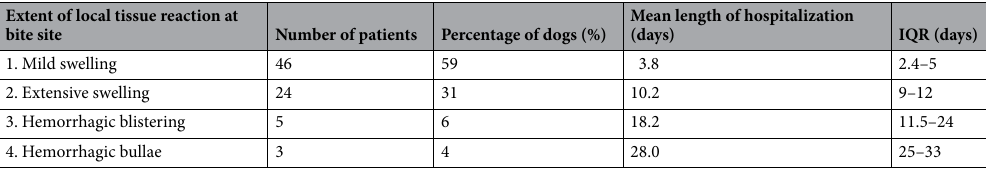
Table 1. Extent of tissue trauma at bite site of dogs. IQR Interquartile